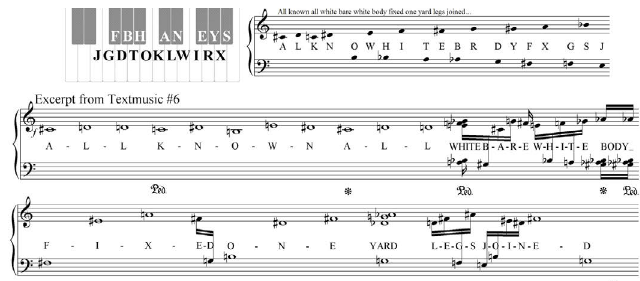
Figure 1: Textmusic #6 – Letter allocation and beginning of